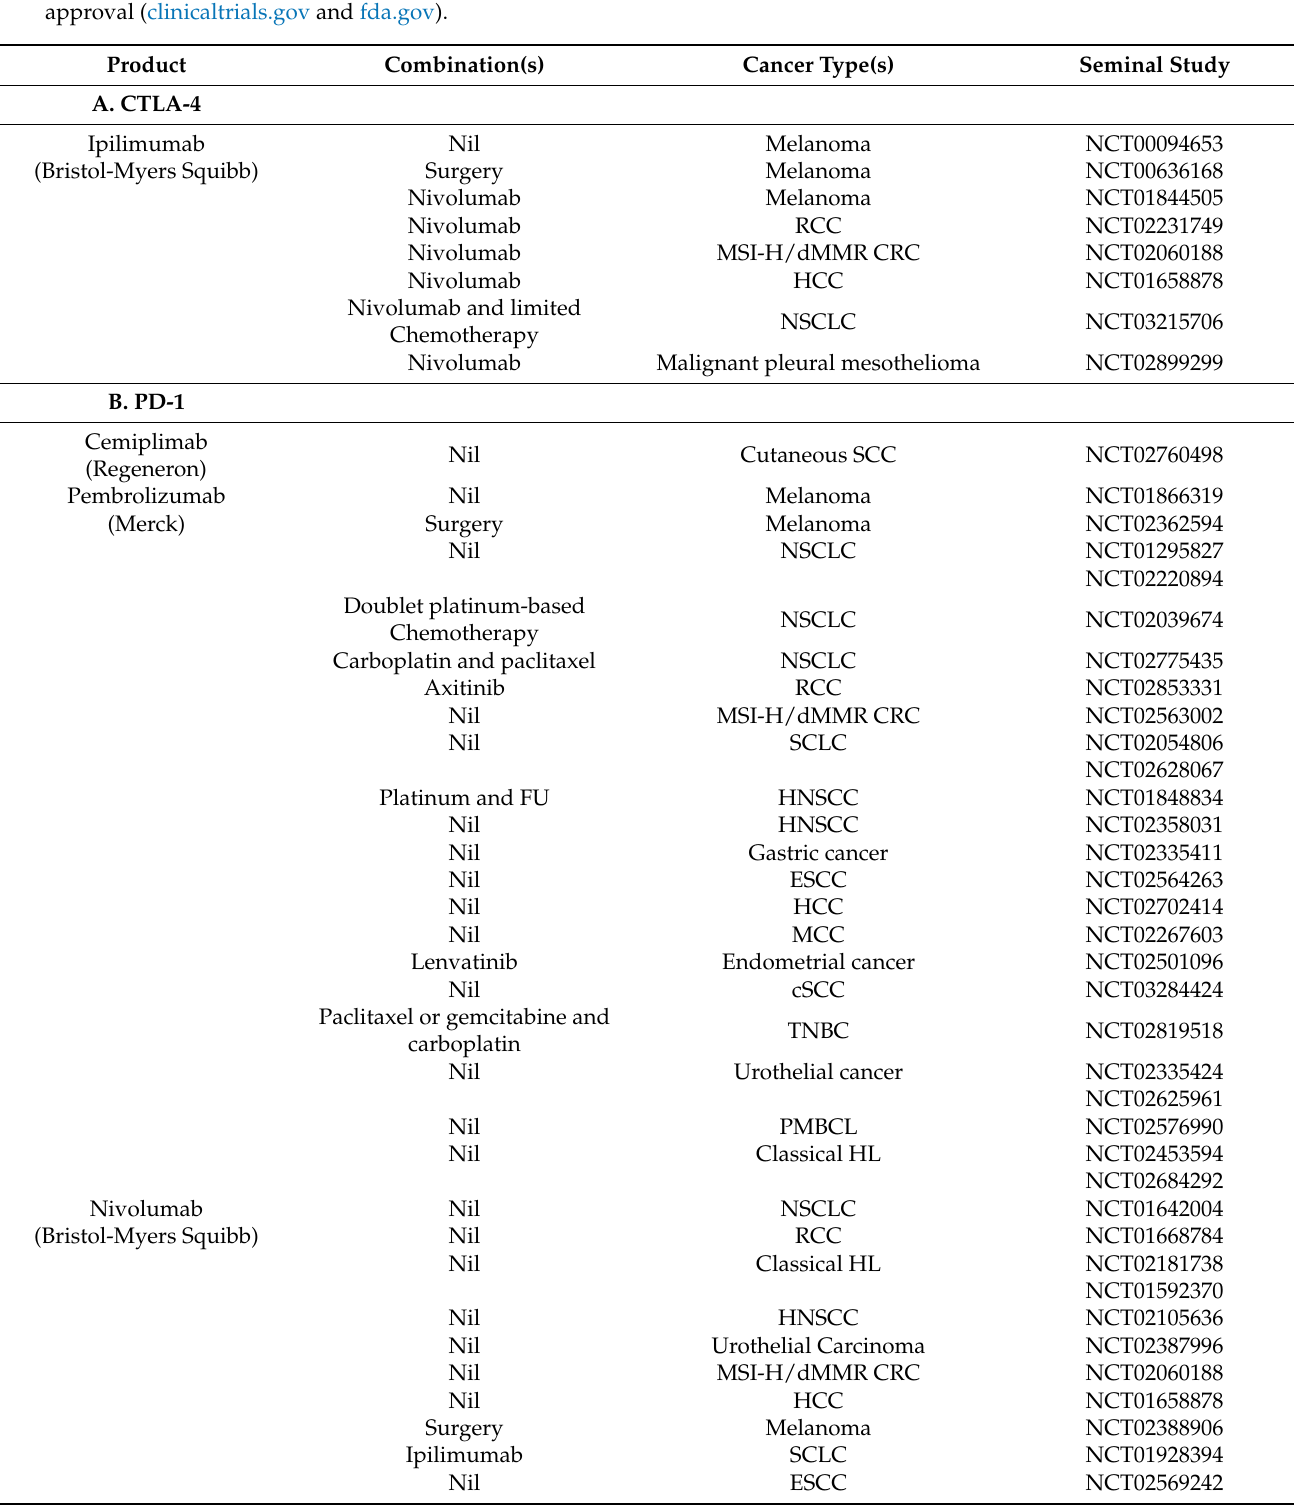
Table 2. Clinical applications of α CTLA-4/ α PD-1 drugs combinations and the seminal studies that lead to their FDA approval (clinicaltrials.gov and